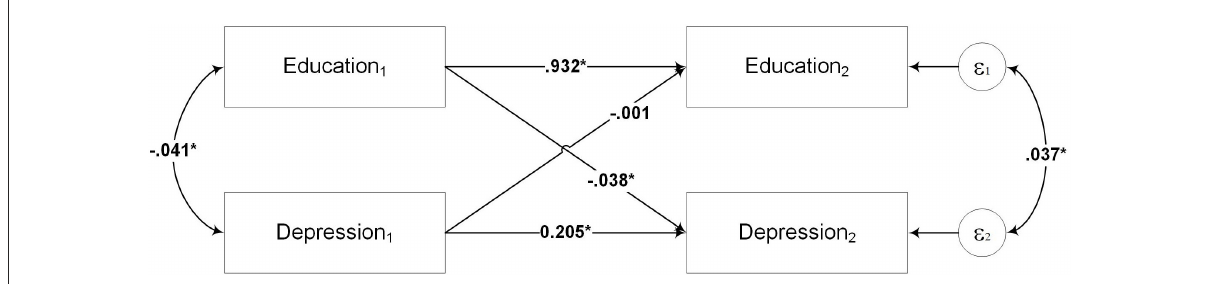
FIGURE1 Model 1 the path analytic model of the cross-lagged relationships between education and depression. Education 1 and Education 2 refer to education levels at Time 1 and Time 2, respectively. Depression 1 and Depression 2 refer to depression at Time 1 and Time 2, respectively. Time 1 is the time of IFLS4 (2007), and Time 2 is the time of IFLS5 (2014). All paths are standardized. * p < 0.01.